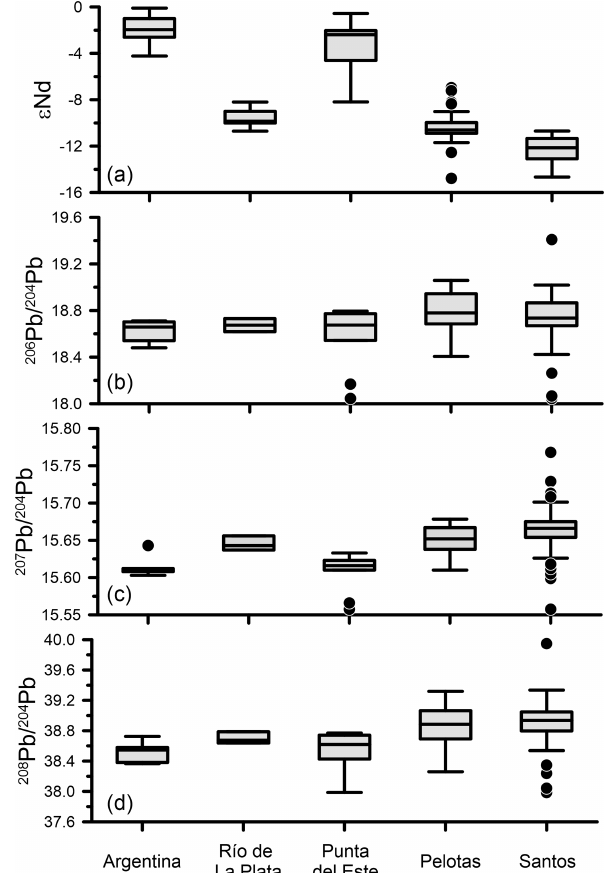
Figure 2. Box plots of the distributions of (a) ε Nd, (b) 206 Pb / 204 Pb, (c) 207 Pb / 204 Pb, and 208 Pb / 204 Pb. Outliers are shown as